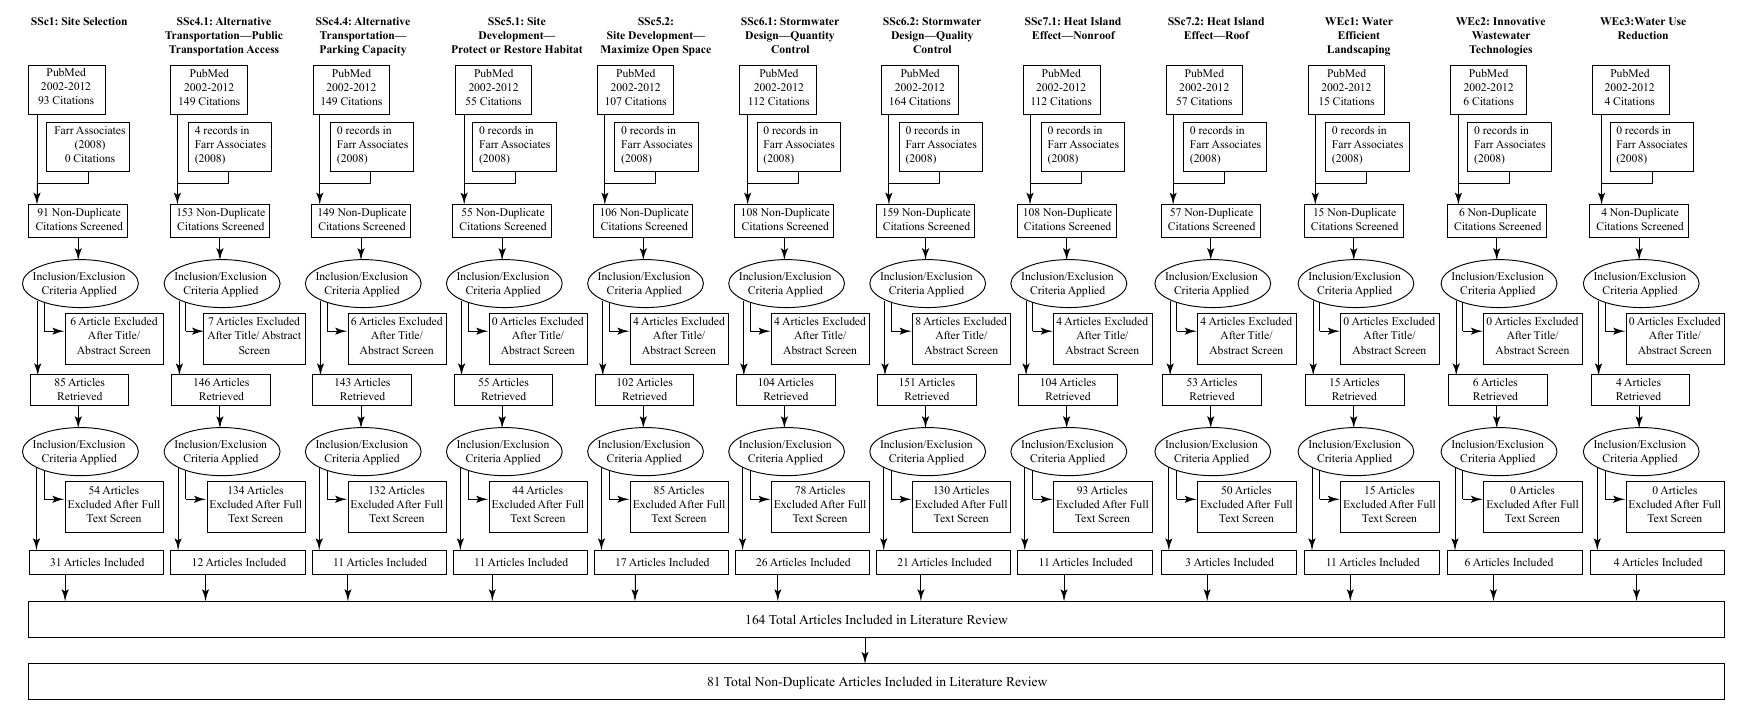
Figure A1. F low Chart of Urban Flooding Literature Review Credit Inclusion Criteria. Note: PRISMA Flow Diagram adapted from Moher et al. (2009) [42].